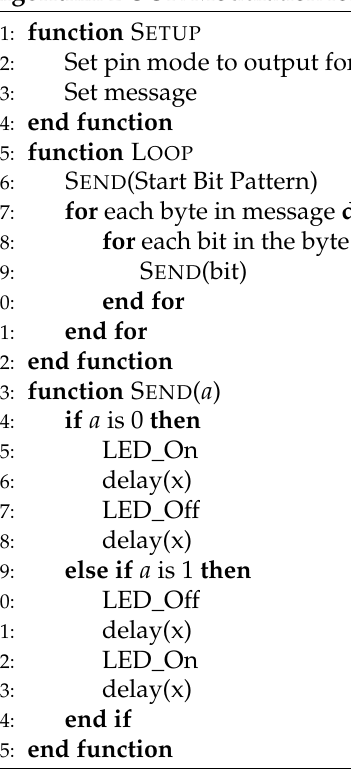
Algorithm 2 OOK Modulation for Li-Fi